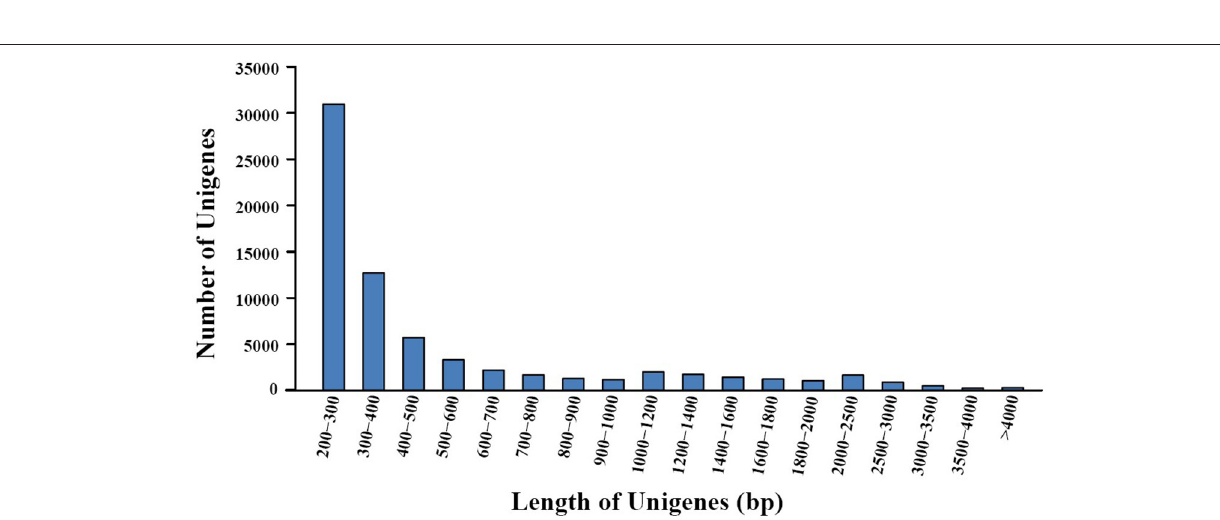
Frontiers in Plant Science | www.frontiersin.org